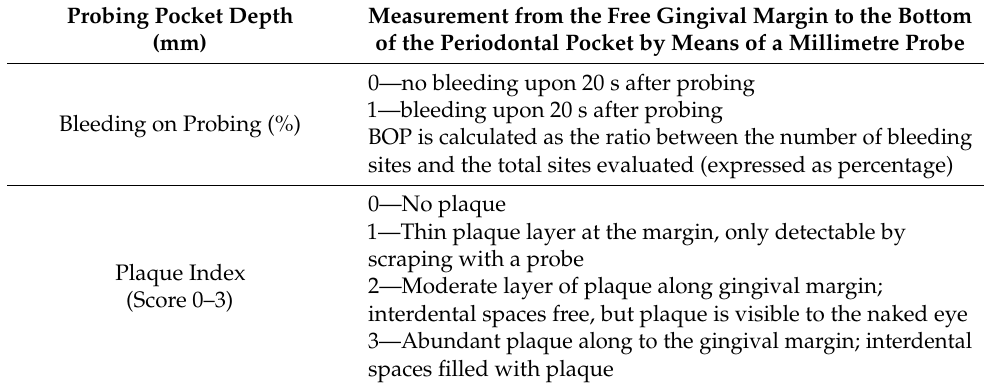
Table 1. Procedures/scores relative to the periodontal parameters